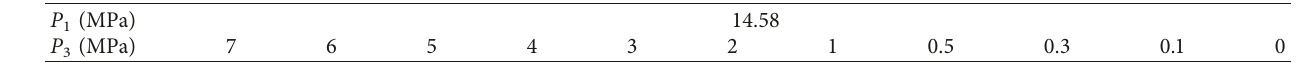
Table 4: Numerical simulation stress conditions.